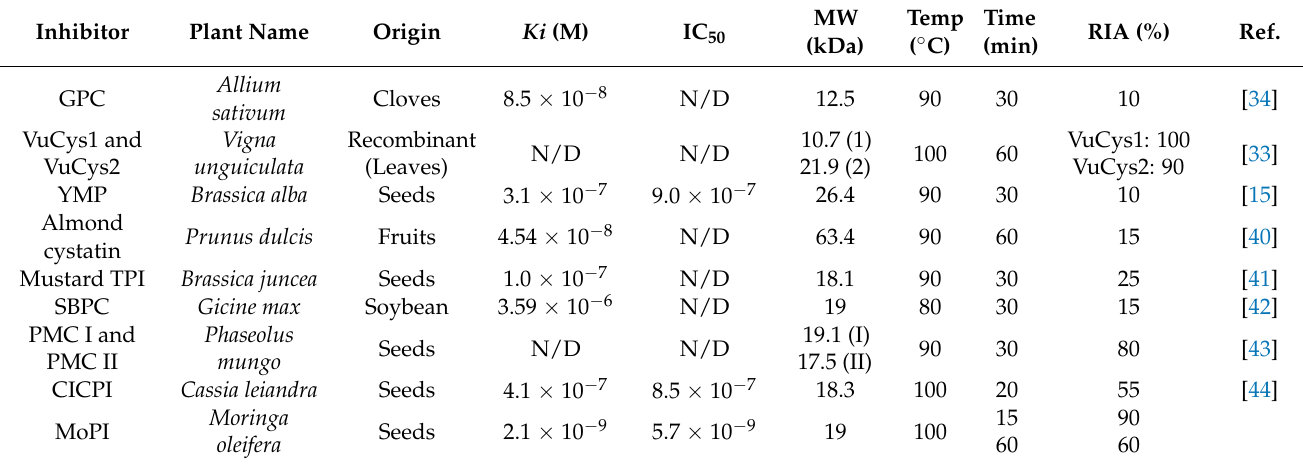
Table 3. Thermostable phytocystatins isolated in the last 20 years.